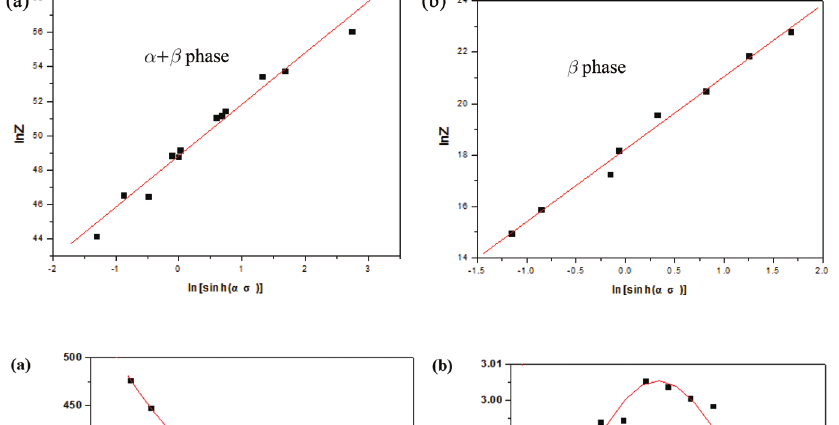
Figure 8: Relationship between lnZ and ln[sinh( ασ )] for (a) α + β phase; (b) β phase.